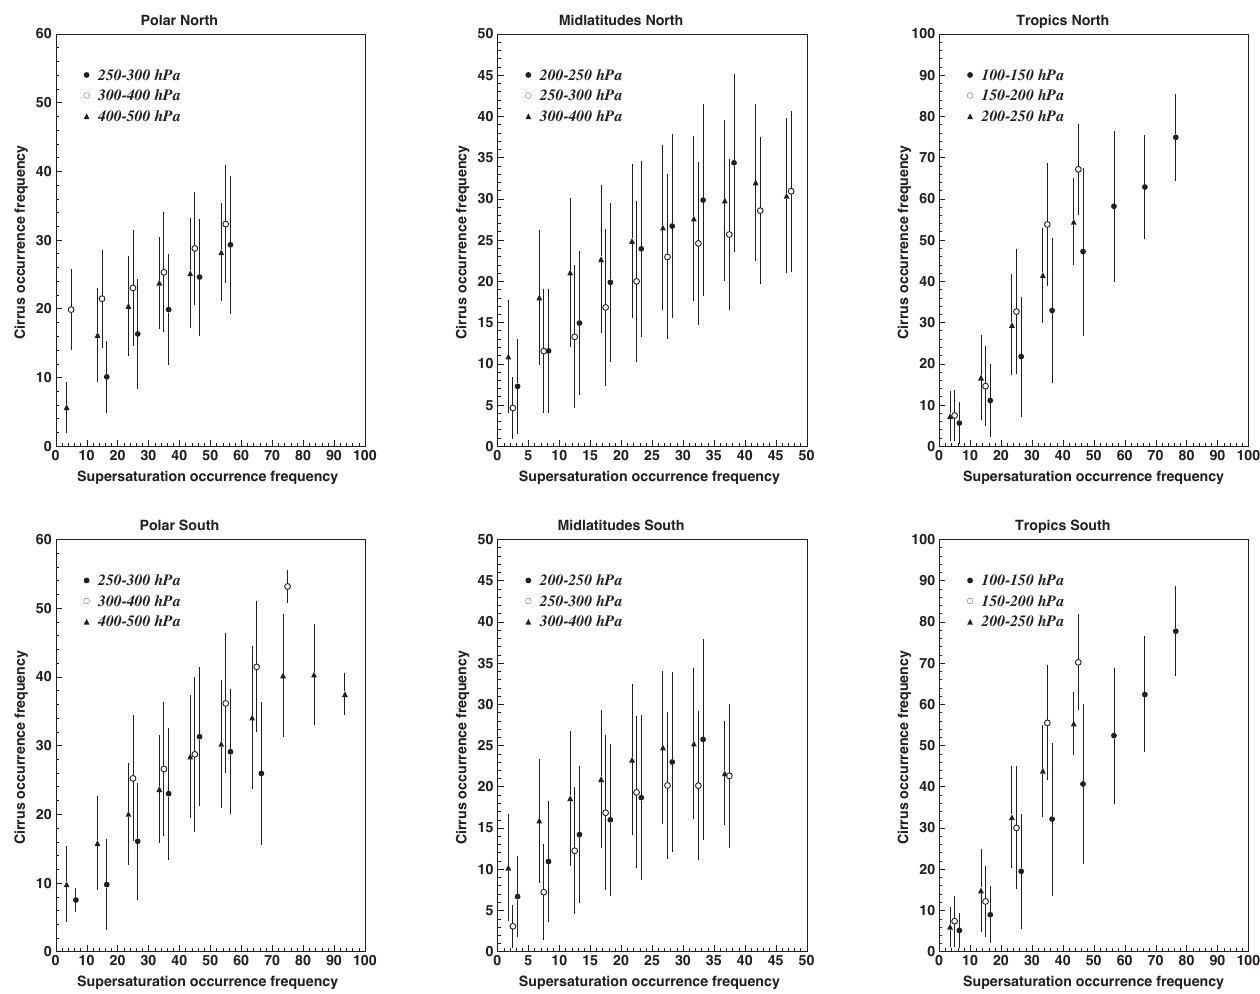
Fig. 14. Relationships between cirus cloud occurrence frequencies (%) determined from CALIOP and ice supersaturation occurrence fre- quencies (%) from AIRS. Polar regions (60–90 ◦ N and S separately), midlatitudes (30–60 ◦ N and S separately), and tropics (0–30 ◦ N and S